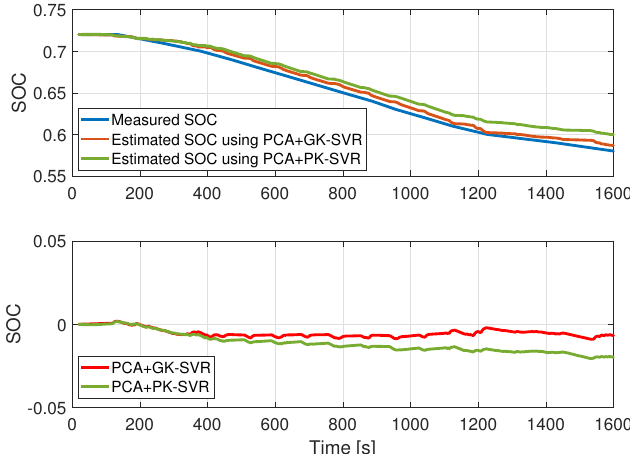
Figure 11. SOC model for Route 2. Top panel: SOC value; bottom panel: Error.